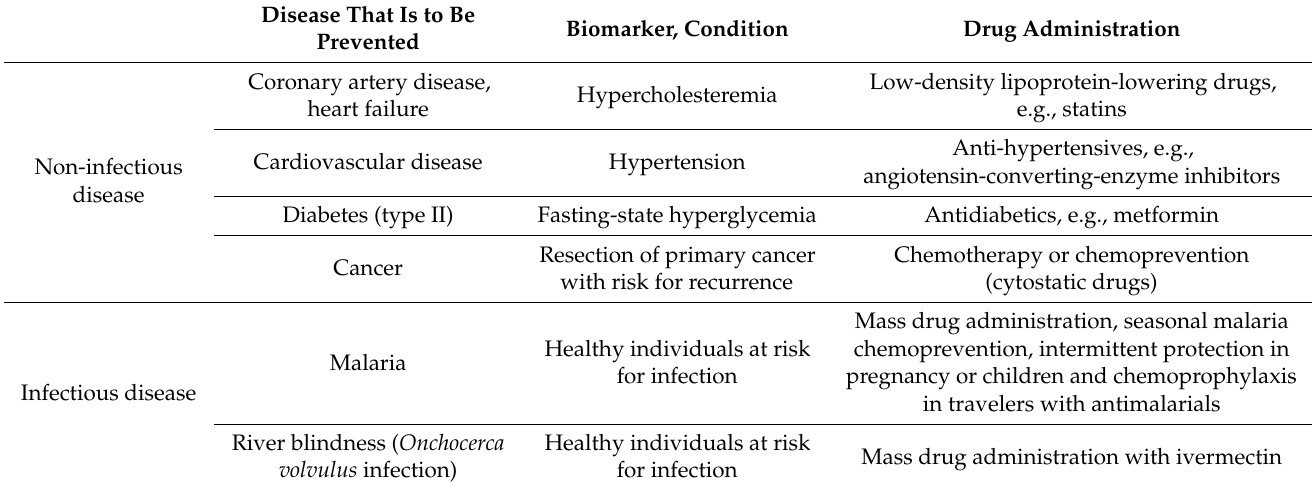
Table 1. Standard ‘chemopreventive’ treatments today, as defined by the use of medicines to prevent disease (and excluding vaccination).